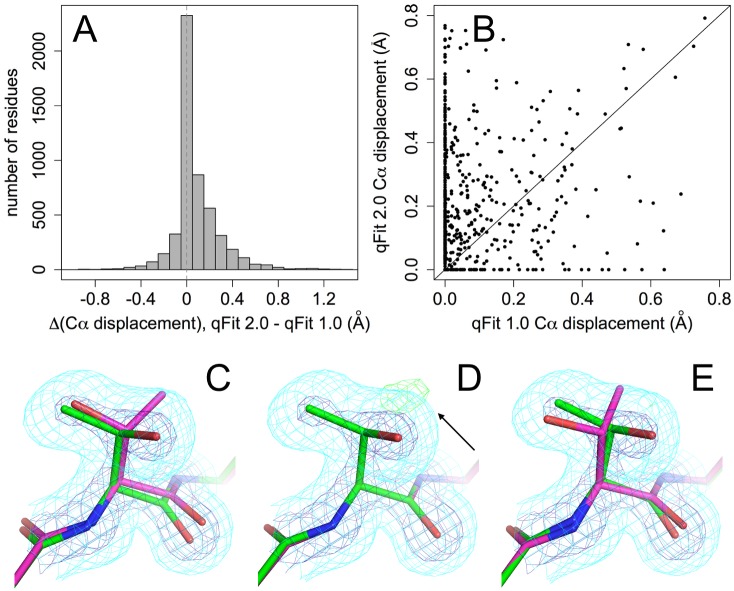
Extra backbone heterogeneity in qFit 2.0 helps discover new sidechain heterogeneity.
(A) Histogram of difference in maximum Cα displacement across all combinations of alternative conformations between qFit 2.0 and qFit 1.0 for the test set. Vertical dotted line at 0 difference. (B) Maximum Cα displacements for qFit 2.0 vs. 1.0 for residues with a newly discovered sidechain rotamer in the qFit 2.0 model but not in the qFit 1.0 model. Many of these residues fall above the diagonal line, meaning the Cα moves more in the qFit 2.0 model than in the qFit 1.0 model. (C-D) Thr157 in cyclophilin A at room temperature (PDB ID 3k0n). 2mFo-DFc electron density is contoured at 0.5 σ (cyan) and 3.0 σ (blue); mFo-DFc difference electron density is contoured at +3.1 σ (green) and -3.1 σ (red). (C) The deposited structure has alternative rotamers that were correctly manually modeled. (D) qFit 1.0 does not move the backbone and misses the alternative rotamer, as evidenced by a peak of +mFo-DFc density (arrow). (E) qFit 2.0 does move the backbone (note especially the backbone carbonyl displacement), and successfully identifies the alternative rotamer.